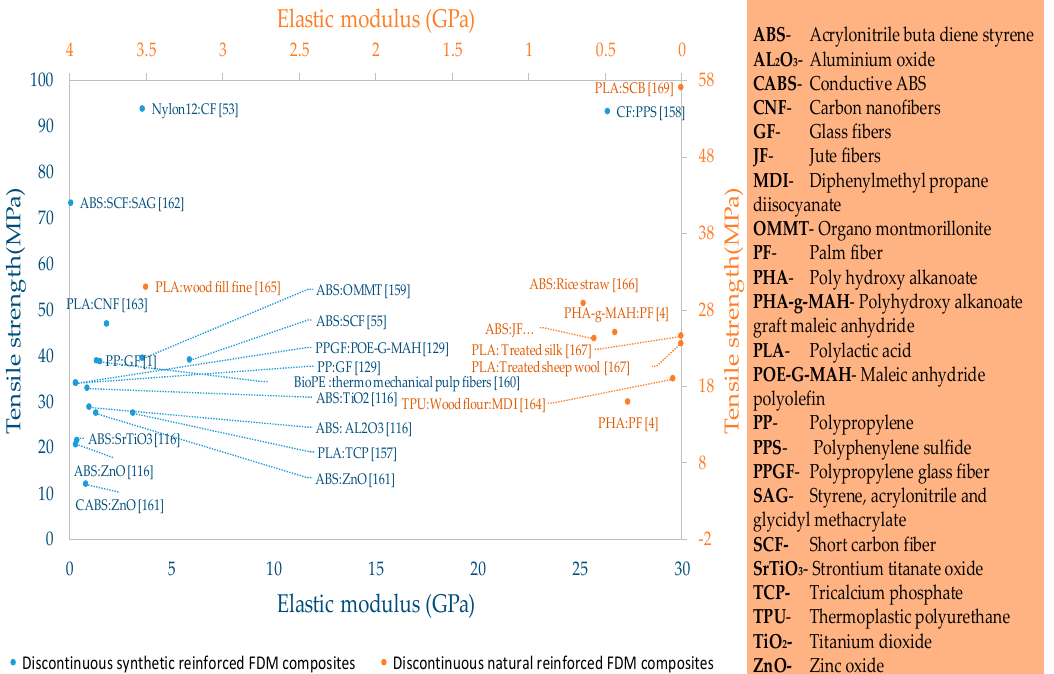
Figure 13. Tensile strength and elastic modulus of discontinuous fiber reinforced materials of fused filament fabrication.